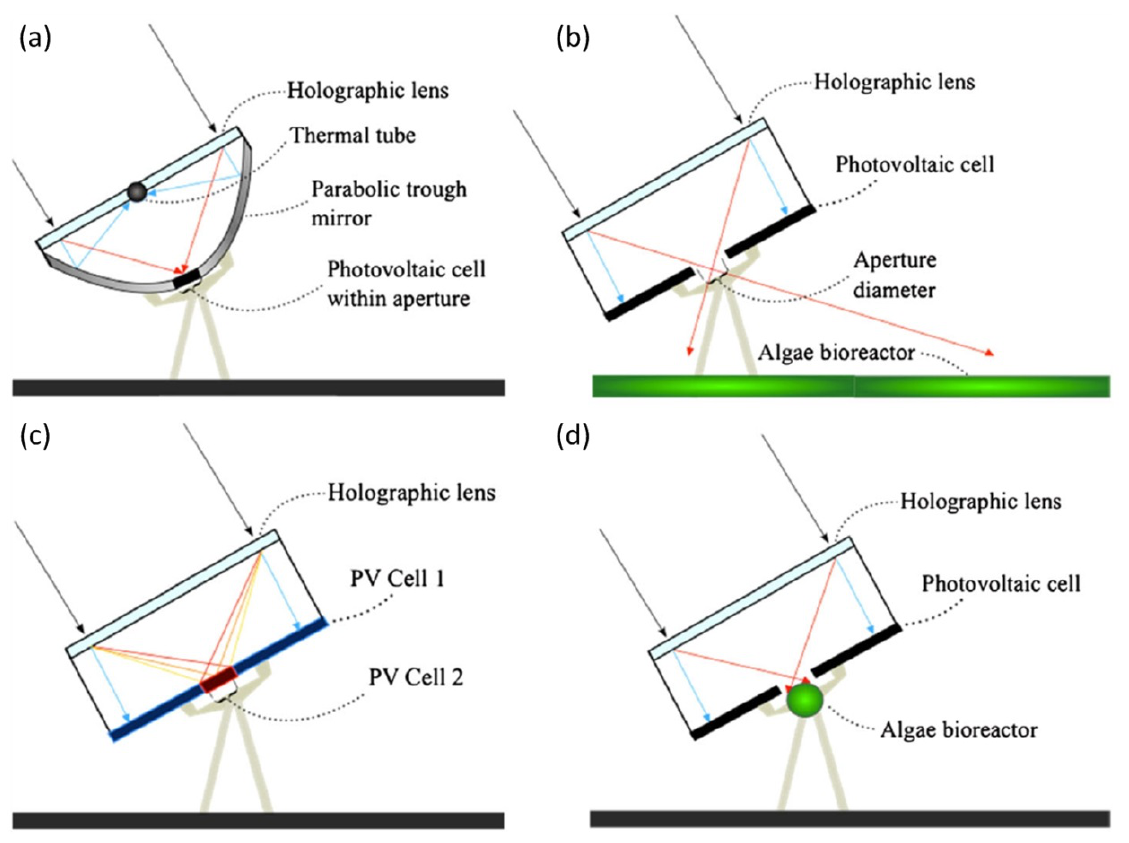
Figure 11: Various spectral splitting systems proposed by Vorndran et al. [114]: (a) Holographic optical element (HOE) across the aperture of a parabolic trough concentrator to selectively redirecting light to either a thermal absorber or PV cells, (b) HOE above flat-plate PV cells, with selective redirection of light to an algae bioreactor, (c) HOE selectively distributing light to different band-gap flat plate PV cells, and (d) HOE selectively distributing light to flat plate PV cells and a tubular algae